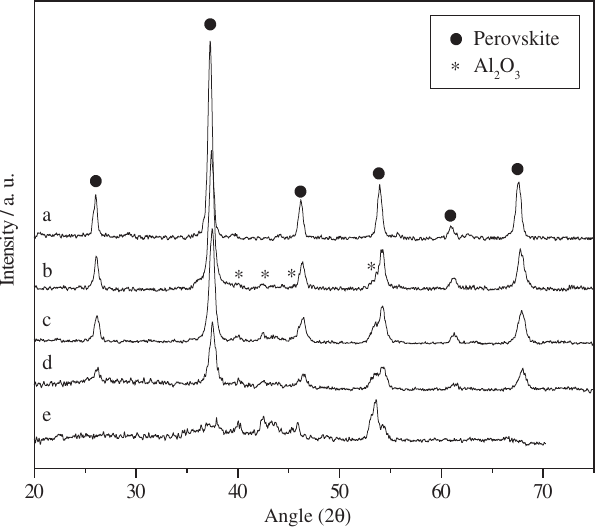
Figure 3. Powder X ray diffraction of the LaFe a) pure (unsupported); b) 50 wt%; c) 33 wt%; d) 25 wt% in perovskite con- tent; and e) Al O 2 3